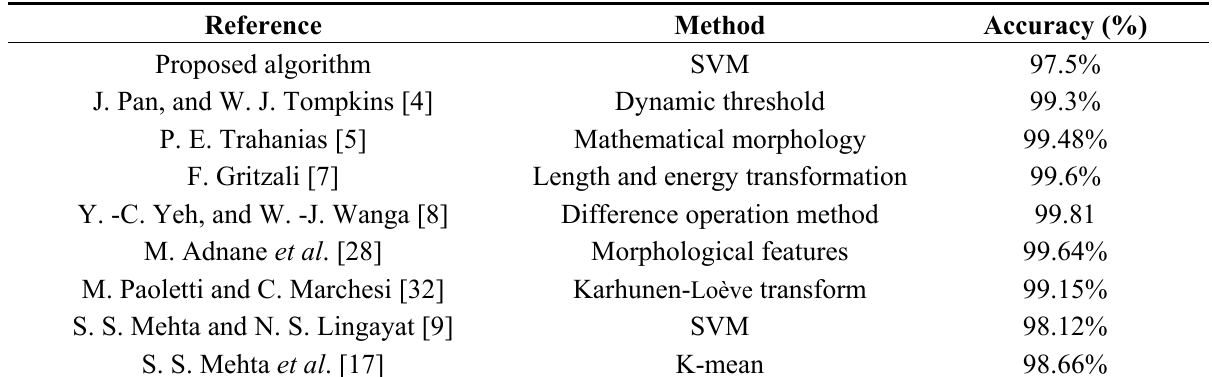
Table 5. Comparison with other QRS detection